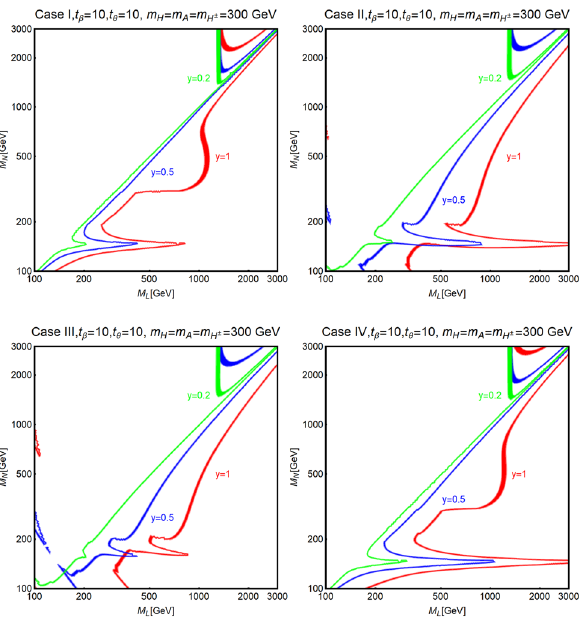
Fig. 7 Isocontours, in the bidimensional plane ( M L , M N ) of the cor- rect DM relic density for three assignations of y , namely 0.2,0.5,1, and for fixed values of the model parameters, as reported on top of the panels. The four panels correspond to the four possible combinations, dubbed Case I-IV, of the couplings of the new fermions with the two Higgs doublets H 1 , 2 (see discussion in the